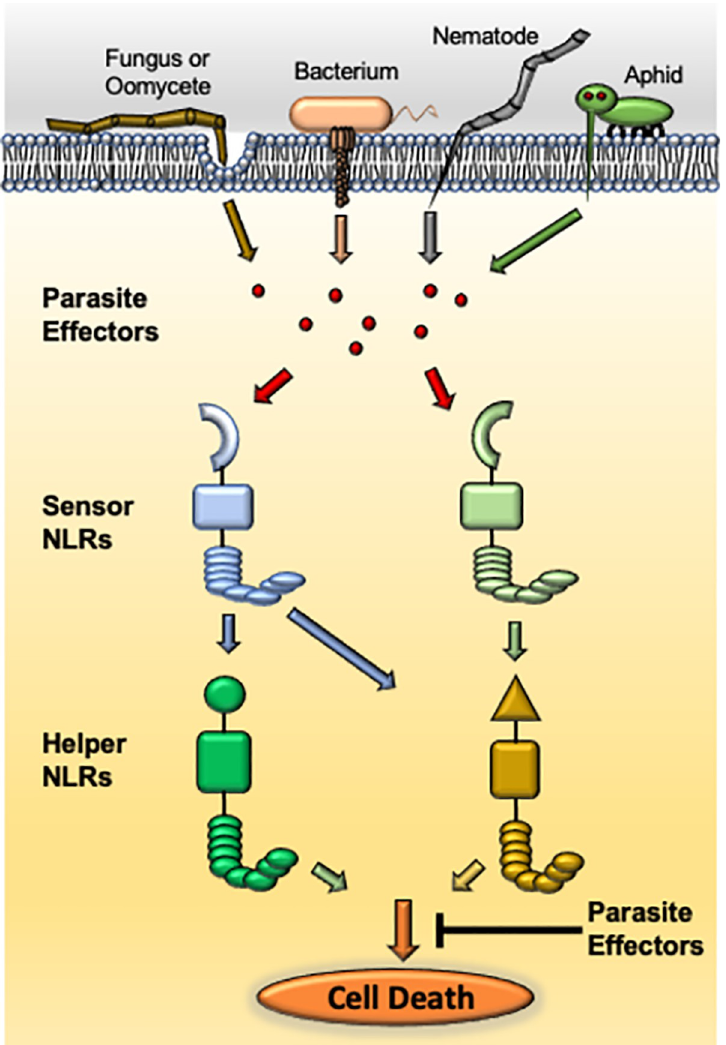
Fig 1. Suppression of NLR immune receptor–mediated cell death by parasitic effectors. Plants recognize effectors secreted from evolutionarily unrelated parasites such as bacteria, fungi, oomycetes, nematodes, aphids, and others via sensor NLRs. This recognition event activates downstream immune signaling leading to cell death, which requires the function of one or more helper NLRs. Derevnina and colleagues [8] used an effectoromics approach to show that parasite effectors interfere with helper NLRs function and suppress the immunity-related cell death response. NLR, nucleotide-binding leucine-rich